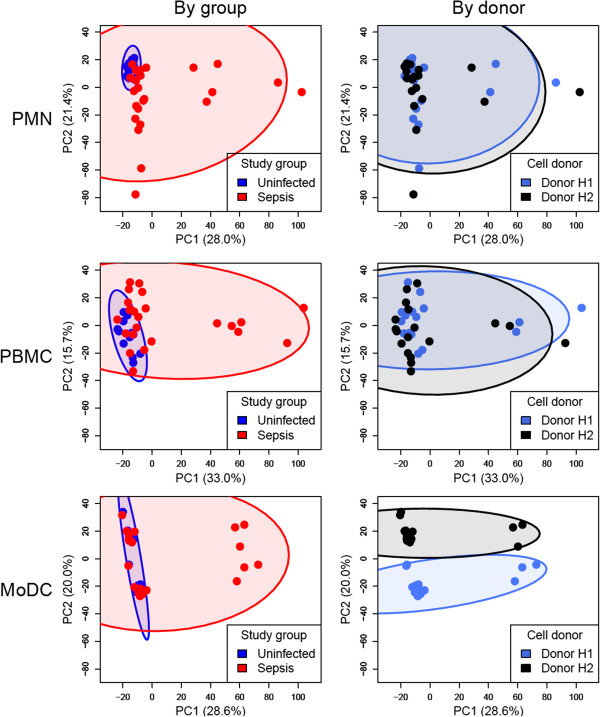
Principal component analyses of transcriptional responses to septic plasma in three different reporter cells systems. The transcriptional response to septic plasma measured by microarrays was analyzed separately for each reporter cell system. Fold-changes were calculated by normalizing the expression levels of cell cultures stimulated with plasma to their respective unstimulated cell cultures. Transcripts passing a filter criteria of 2 fold-change and 100 difference in intensity (2FC100DIF) were used for principal component analysis (PCA). Scores from principal component 1 (PC1) and principal component 2 (PC2), which explain approximately 50% of the variability, were plotted. Samples were color-coded according to study groups (blue = uninfected plasma; red = septic plasma; left panels) or cell donors (blue = donor H1; black = donor H2; right panels). Each ellipse indicates the 95% confidence interval of data from the corresponding group (indicated by colors). Numbers in parentheses indicate percentage of variance.